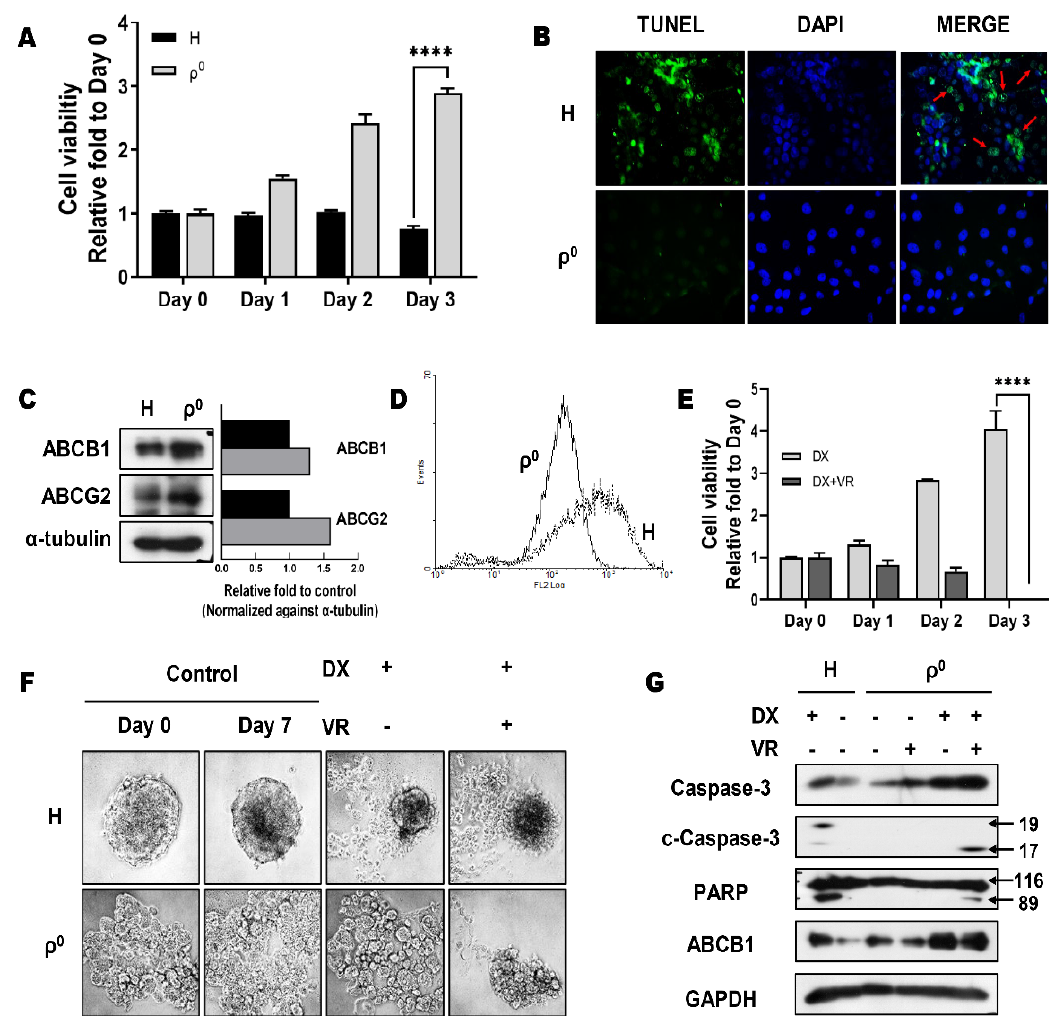
Figure 2 . Hep3B/ ρ 0 cells exhibit drug resistance via ATP-binding cassette (ABC) transporters. The effect of mitochondrial dysfunction on drug resistance was determined using crystal violet ( A ) and TUNEL assays ( B ). ( A ) Cells were treated with doxorubicin (2 μ M) for 72 h (**** p < 0.0001). ( B ) TUNEL staining was evaluated using fluorescence microscopy at 20 × magnification. Green (arrow) indicates TUNEL-stained cells (apoptotic cells). ( C ) Western blot analysis was used to measure the protein levels of ABC transporters in Hep3B/ ρ 0 cells. Graph showing respective molecule levels normalized to the loading control. Black box: Hep3B. Grey box: Hep3B/ ρ 0 . ( D ) Flow cytometry analysis of Hep3B (dashed line) and Hep3B/ ρ 0 (bold solid line) treated with rhodamine 123. Rhodamine 123 fluorescence was measured by fluorescence-activated cell sorting. ( E ) The effect of the ABCB1-specific inhibitor verapamil on doxorubicin-induced cytotoxicity was examined by MTT assay (**** p < 0.0001). ( F ) The cytotoxicity of doxorubicin in 3D-culture (sphere-forming). ( G ) Western blot analysis of apoptosis markers after treatment with doxorubicin and